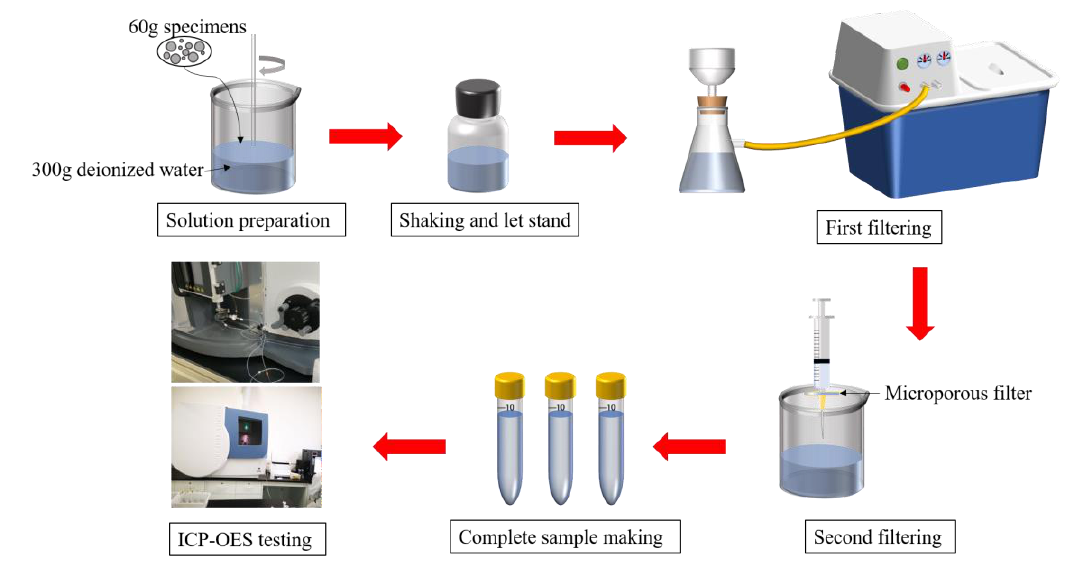
Figure 3. ICP-OES testing.